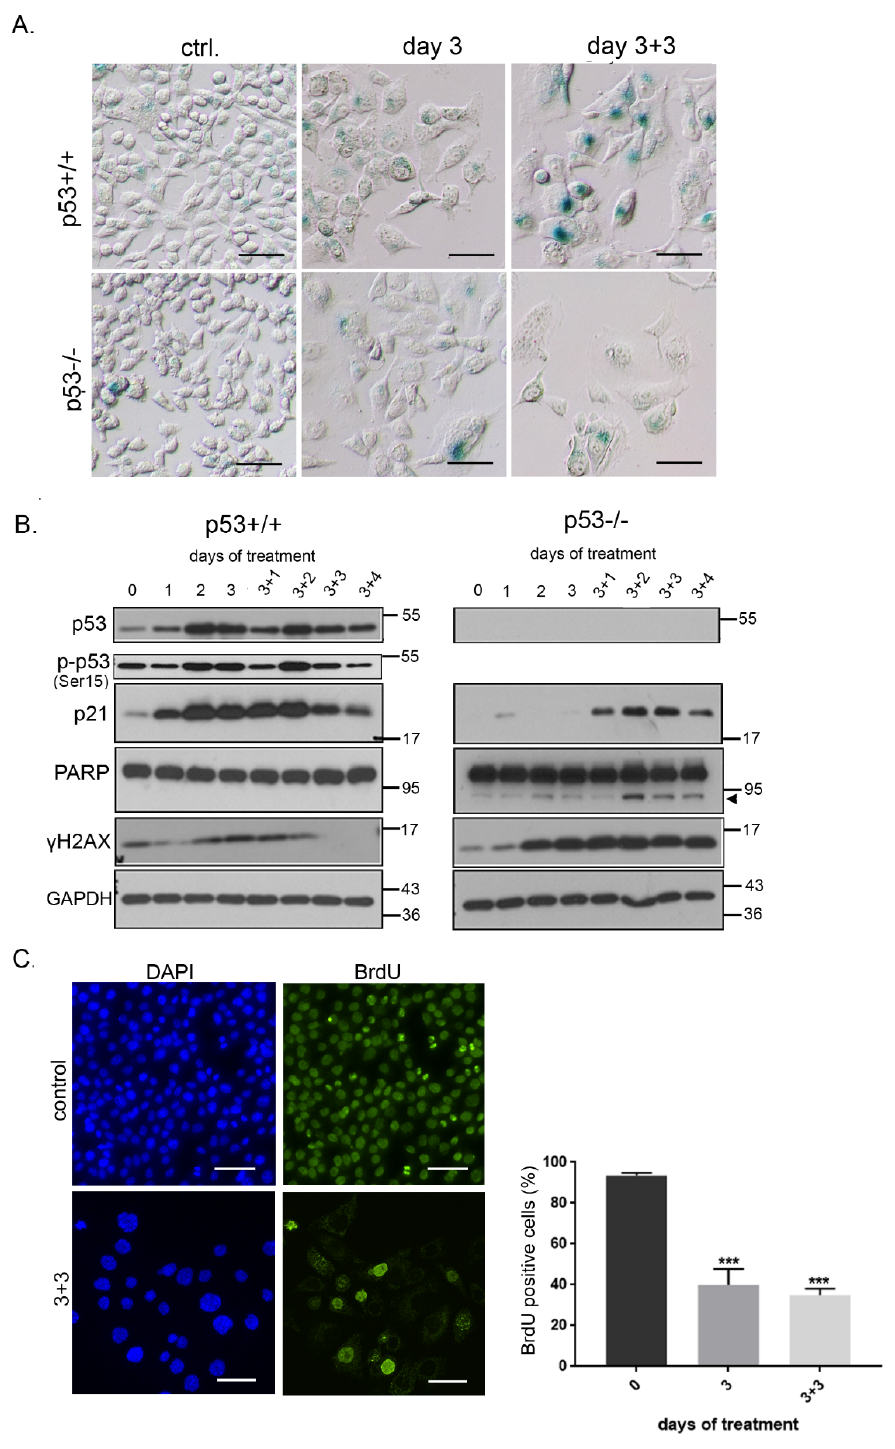
Figure 5. DPI treatment induces senescence of HCT116 cells. ( A ) HCT116 cells were treated with 0.5 μ M DPI for 3 days and SA- β -gal activity was analyzed; ( B ) the level of protein markers of senescence—p53, p-p53 and p21, and apoptosis—PARP cleavage (indicated by arrowhead) and γ H2AX—was estimated at different time points after DPI (0.5 μ M) treatment. ( C ) BrdU incorporation analysis was performed in HCT116 p53+/+ cells. The percentage of cells that were able to incorporate BrdU within 24 h of culture is presented on the graph (mean ± SD, four experiments); *** p ≤ 0.001.